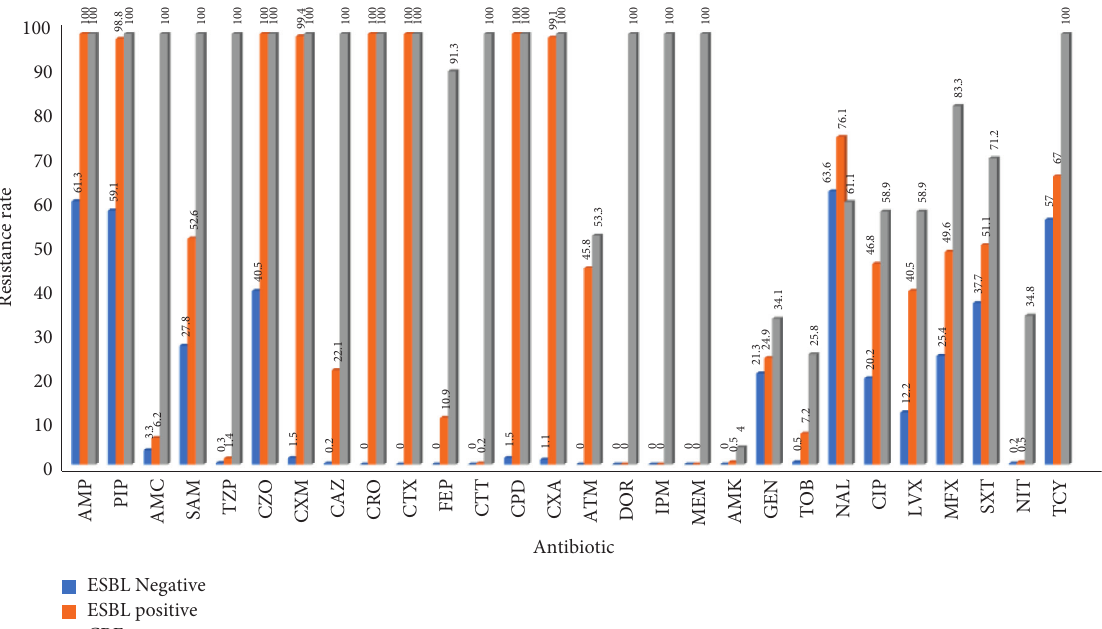
Figure 19: Distribution of drug resistance of E. coli from 2018 to 2020